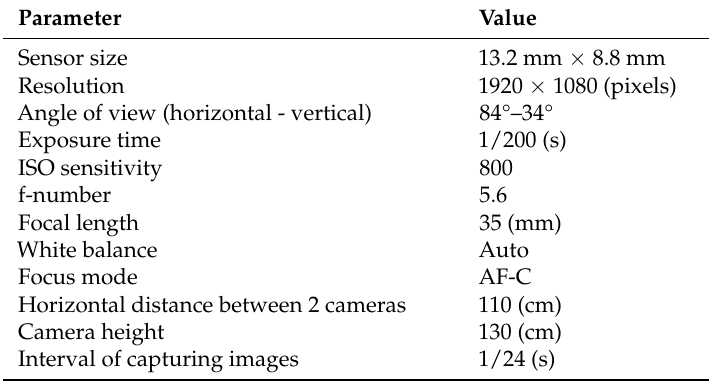
Table 3. Experimental